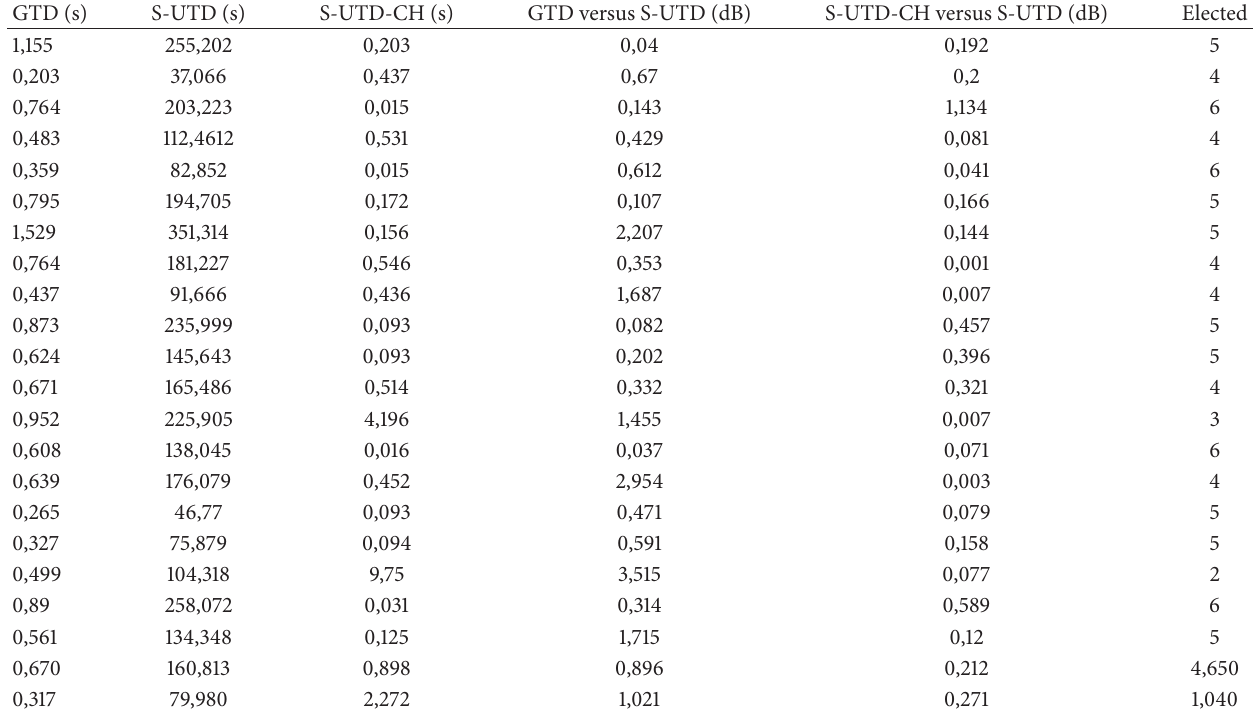
Table 5: Comparison results of highly lowered receiver height